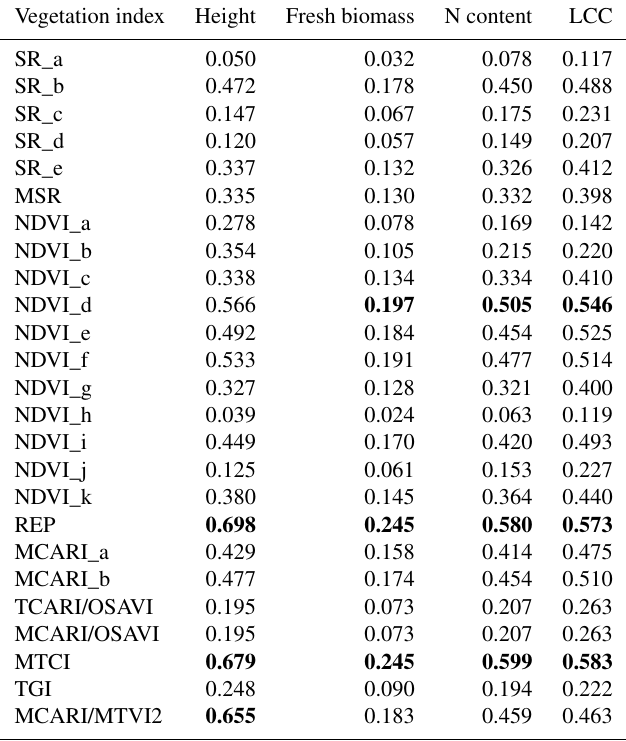
Table 4. Coefficients of determination ( R 2 ) based on a linear regression for the calibration set between existing vegetation indices (VI) and the studied plant traits. LCC: leaf chlorophyll content. The three models producing the highest coefficients for each trait are displayed in